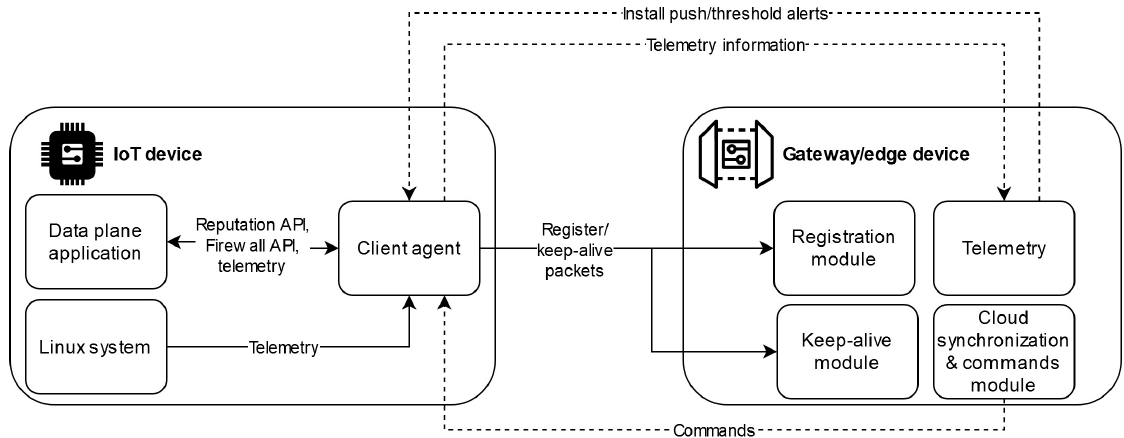
Figure 2. The communication between client and